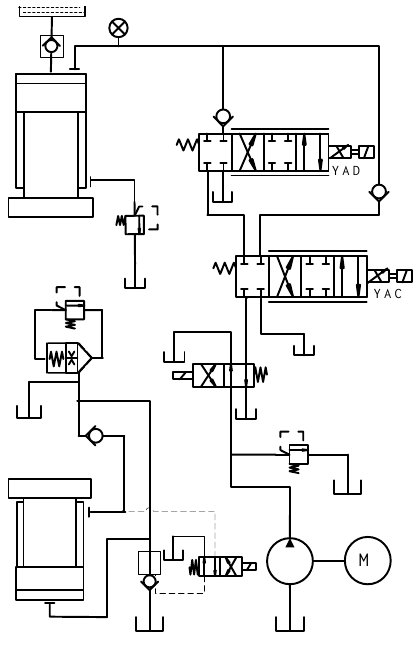
Figure 1. Typical structure of forging machine [38].